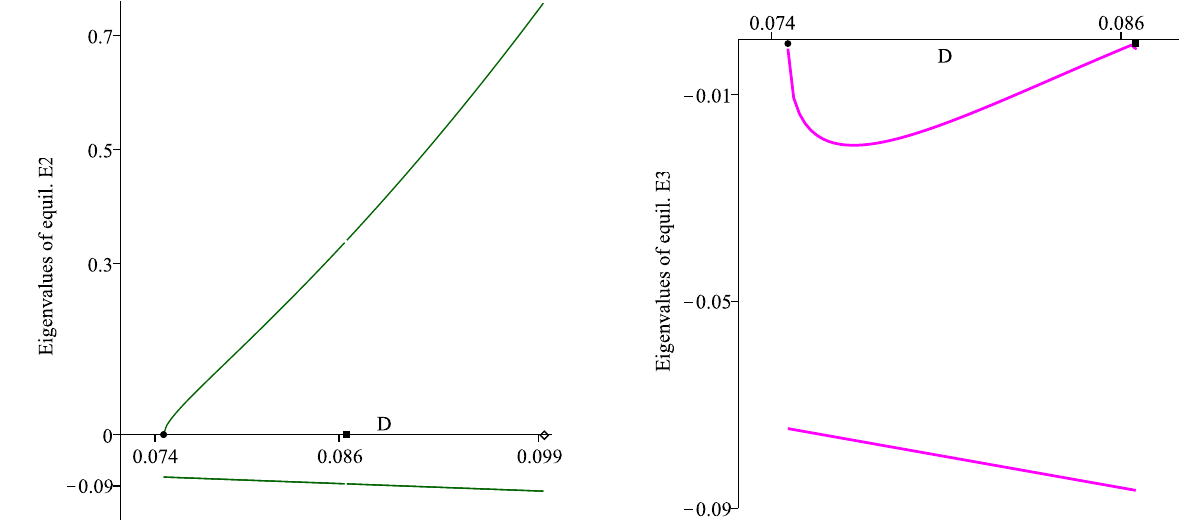
Figure 3. Eigenvalues corresponding to the equilibrium points E 2 ( left ) and E 3 ( right ), parameterized on D . On the horizontal axis, the solid circle denotes D